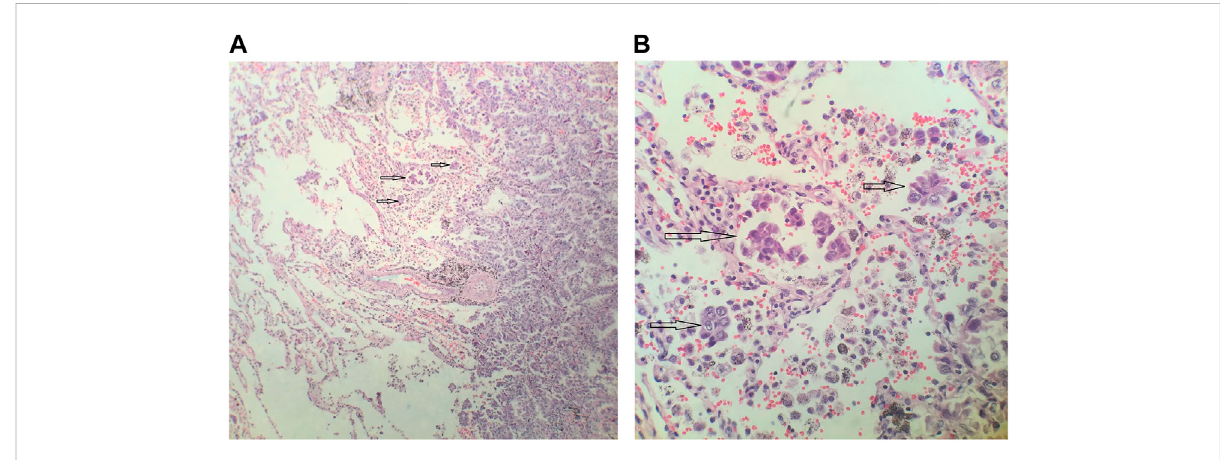
FIGURE 1 Representative histopathologic images of spread through air spaces (STAS) in lung adenocarcinoma. (A) Magni fi cation×100 (B). Magni fi cation